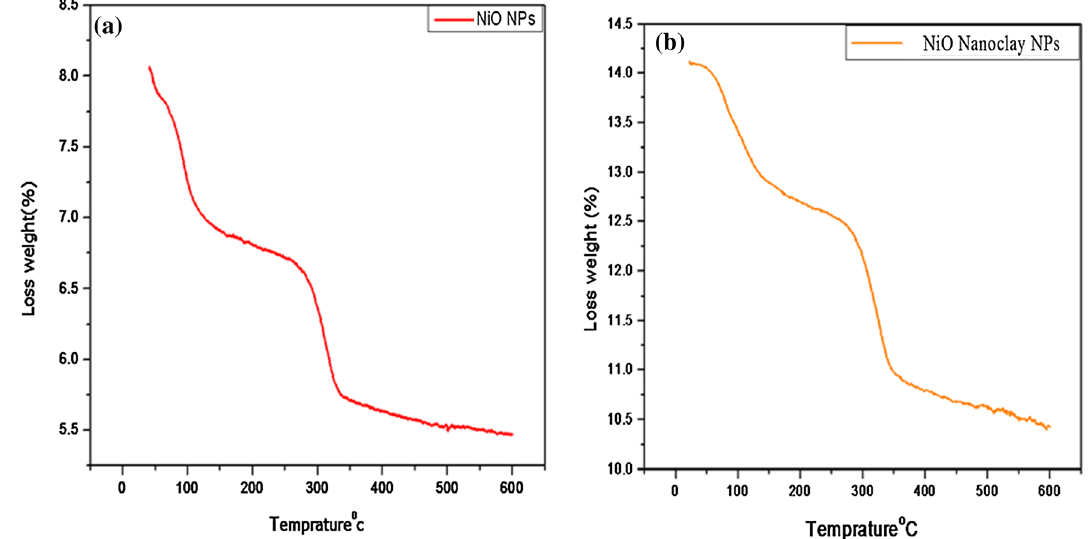
Fig. 4 TGA analysis of a NiO NPs b NiO/Nc